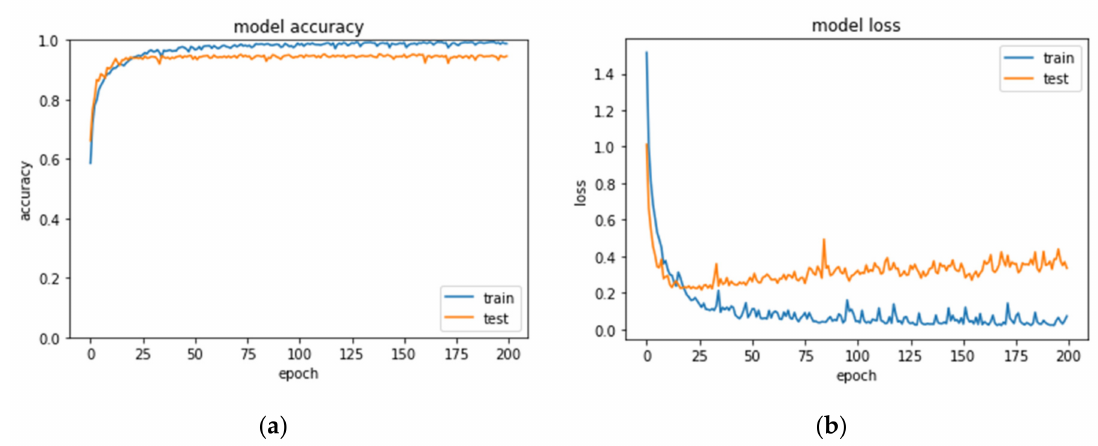
Figure 7. Accuracy Curve ( a ) and Loss Curve ( b ) of the hyper-parameters optimize Le-net5 model trained on the MMCC dataset. Table 4. Results of the training of Le-net5 on MMCC dataset, where the hyper-parameters